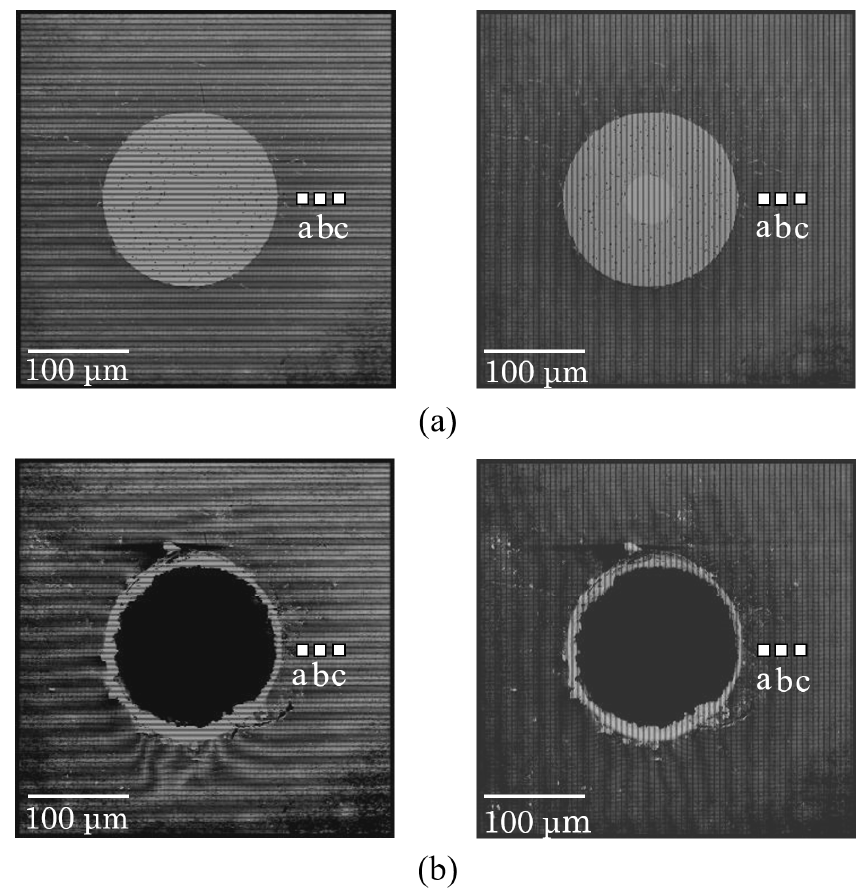
Figure 12. Difference in the Moiré patterns ( a ) before and ( b ) after metal-core piezoelectric fiber indentation.